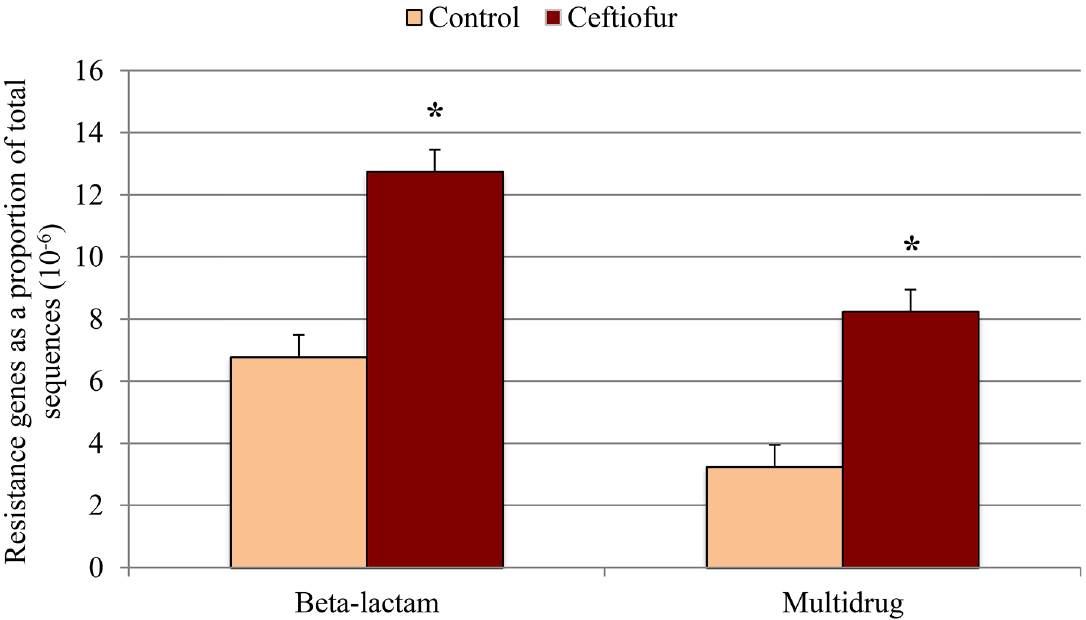
Fig 2. Abundance of β -lactam and multidrug resistance genes in fecal samples collected from control (n = 3) and ceftiofur crystalline free acid treated (n = 3) cows on 3 post-treatment. Day 0 (pre-treatment) samples were used as a covariate. Values are expressed as a percentage of the total sample sequences (x 10 − 6 ). The symbol * indicates significant ( P (cid:1)